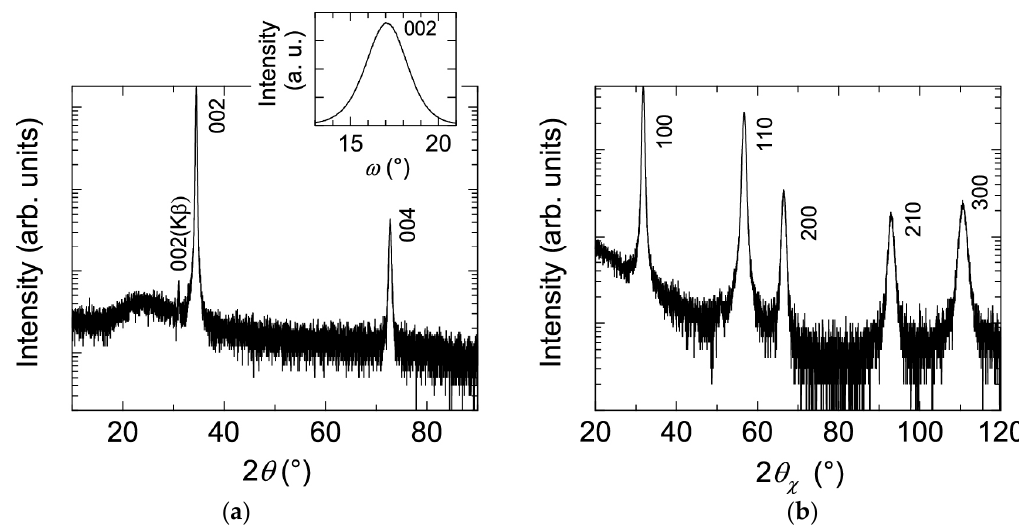
Figure 1. ( a ) θ –2 θ scan (out-of-plane) with 002 ω scan; and ( b ) 2 θ x – ϕ scan (in-plane) XRD patterns of a ZnO:Al (2.0 wt %) film.